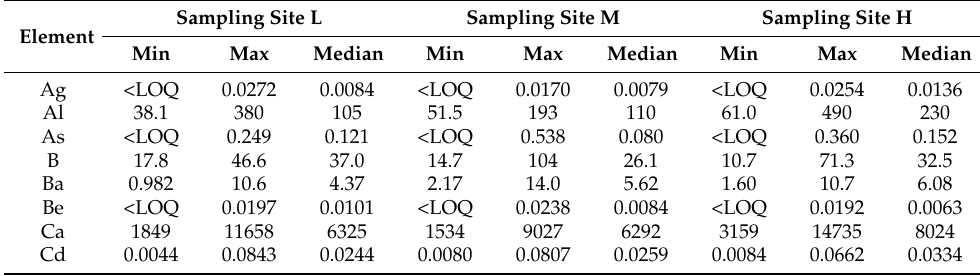
Table 1. Elemental content in the dried needle samples from all sampling sites in